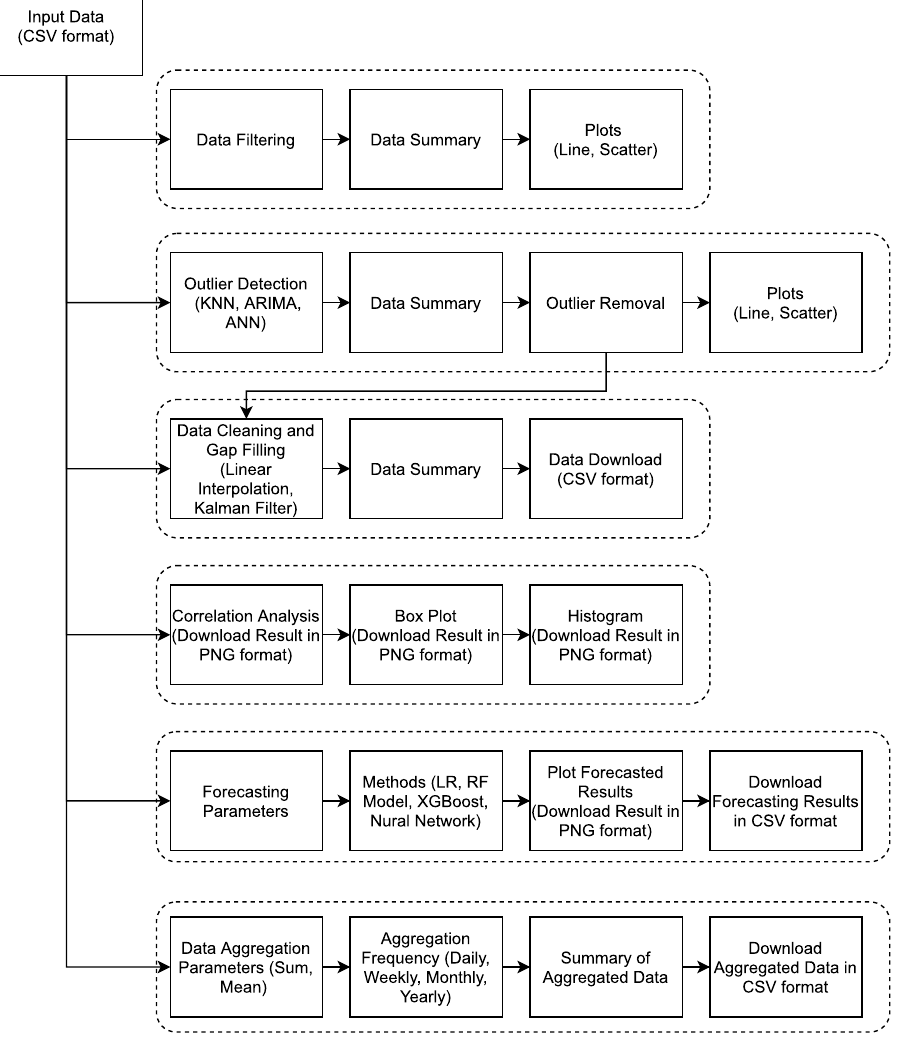
Figure 9. Schematic of the exploreR